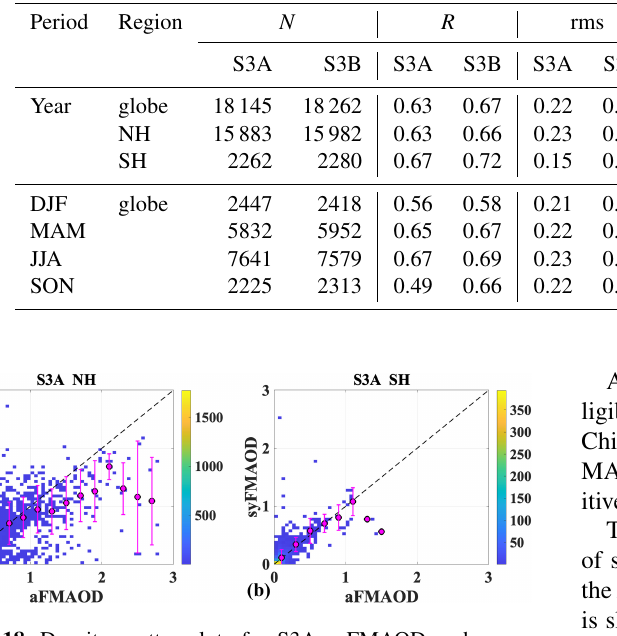
Figure 18. Density scatter plots for S3A syFMAOD and corre- sponding aFMAOD for collocations available over the NH (a) and SH (b)